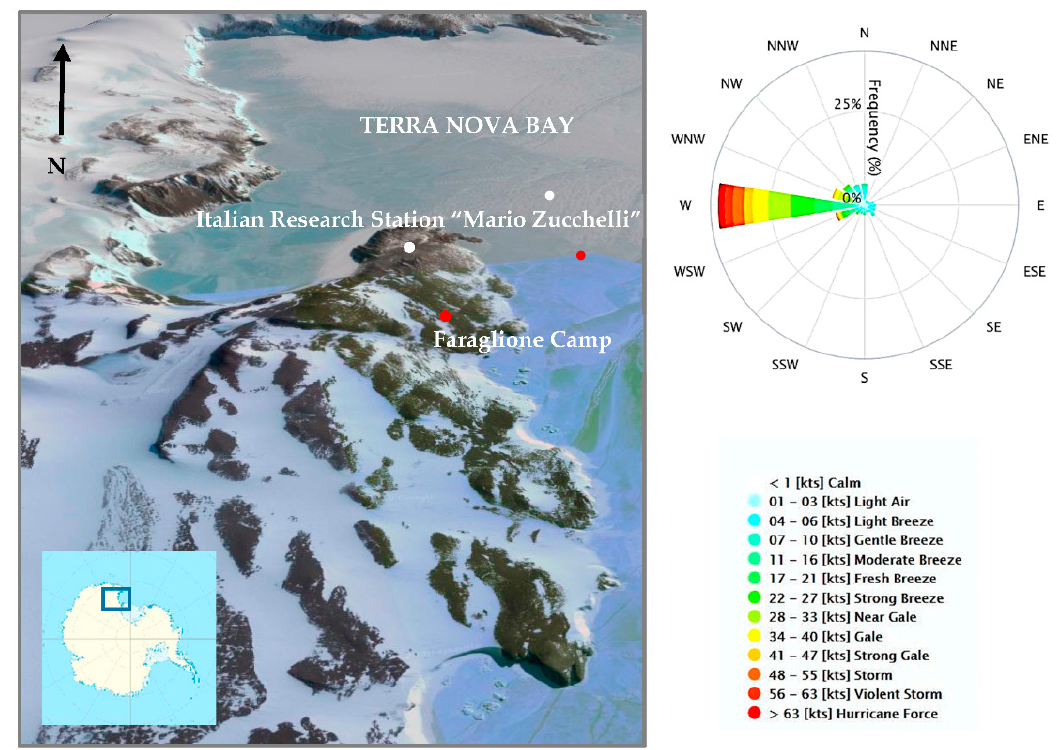
Figure 1. Map of Terra Nova Bay with the position of the sampling site (Faraglione Camp) and of the Italian Mario Zucchelli Station (MZS). The wind rose with the prevailing wind direction for the 2013–2014 Antarctic summer is also reported.